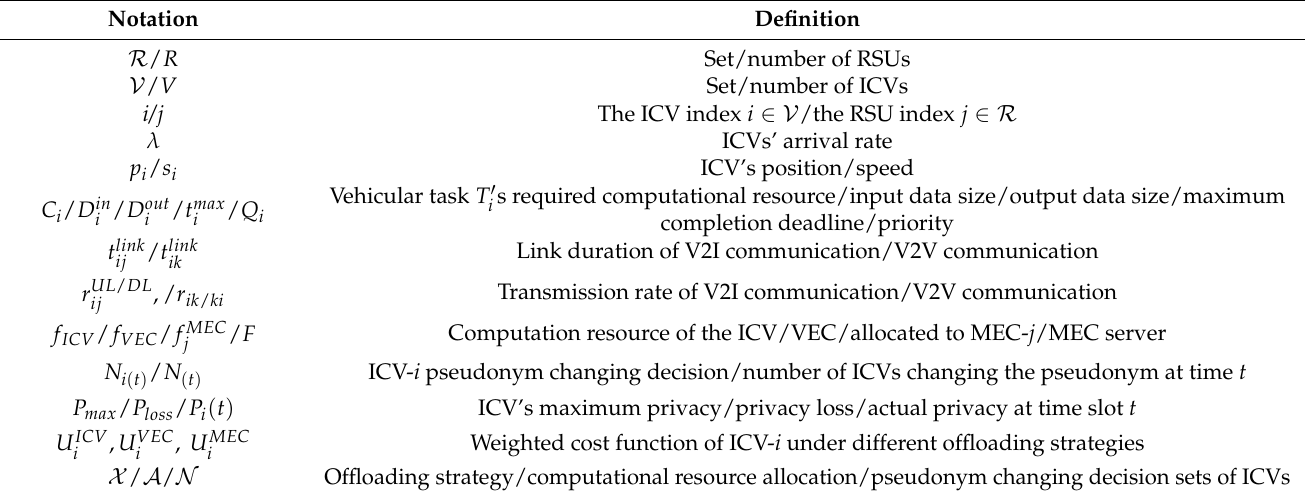
Table 1. List of main